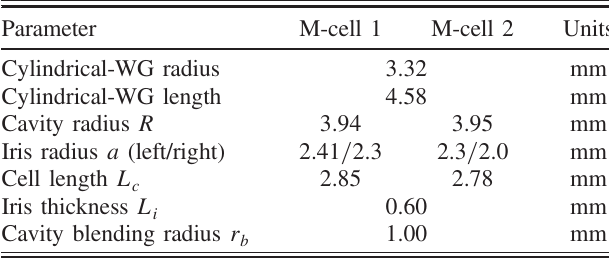
TABLE V. Mode launcher geometrical